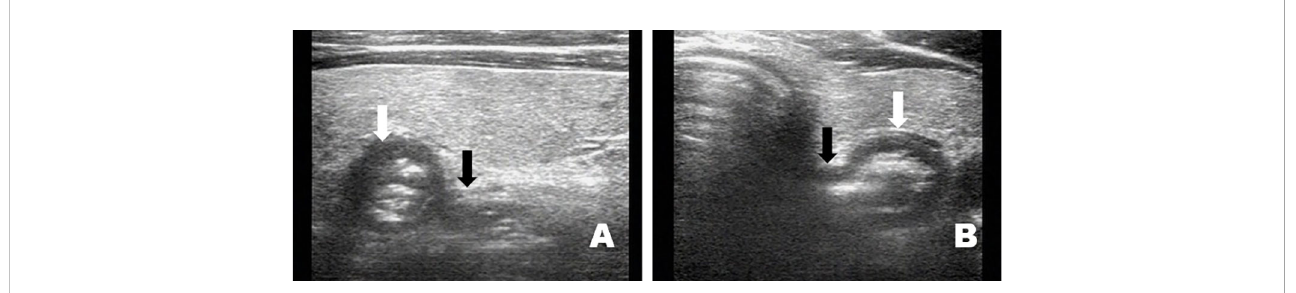
FIGURE 4 The solid nodular diverticulum wall and esophageal wall are continuous if viewed with multiple sections such as crosscut and then cut scanned (A) , image from a 21-year-old man: (B) , image from a 39-year-old